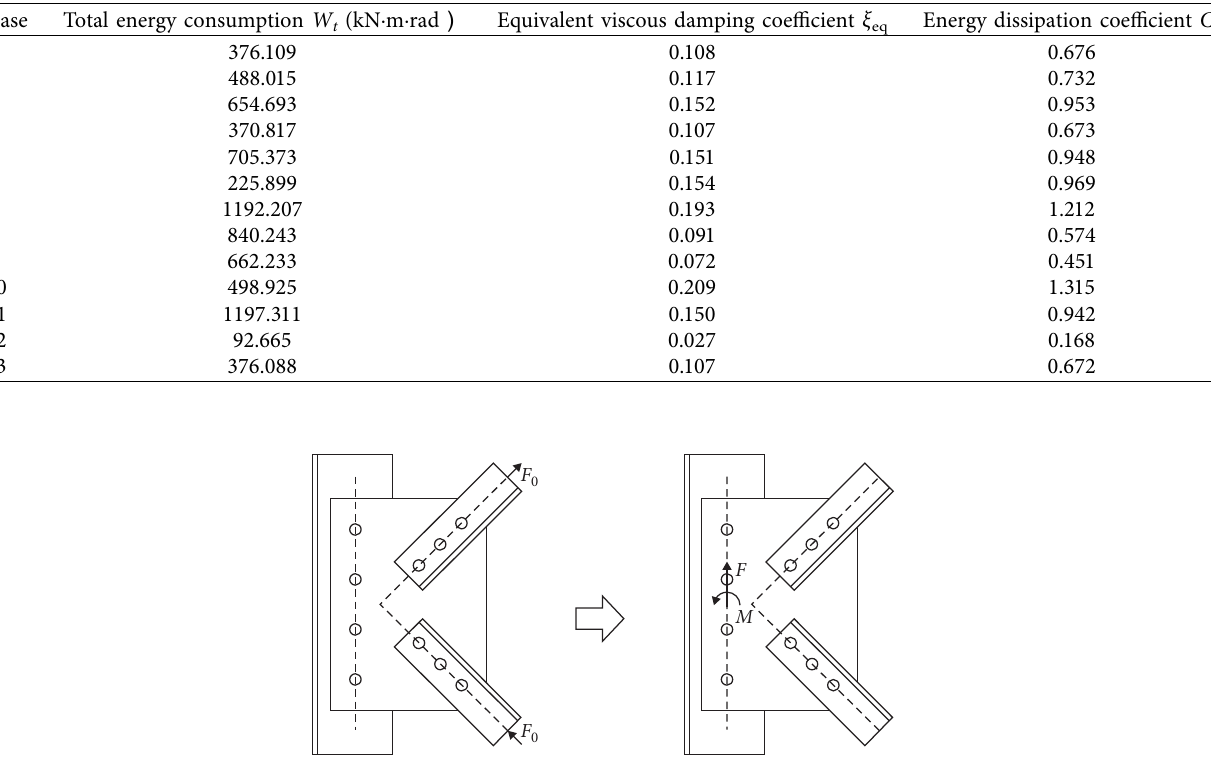
Figure 7: Mechanism of the K-joint under the most unfavorable